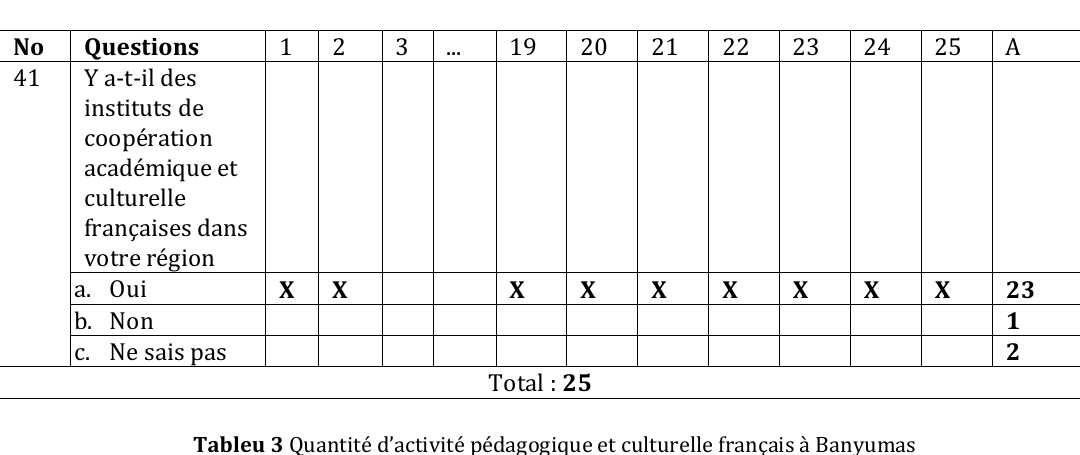
Tableu 2 Connaissance de bureau culturelle dans le quartier des